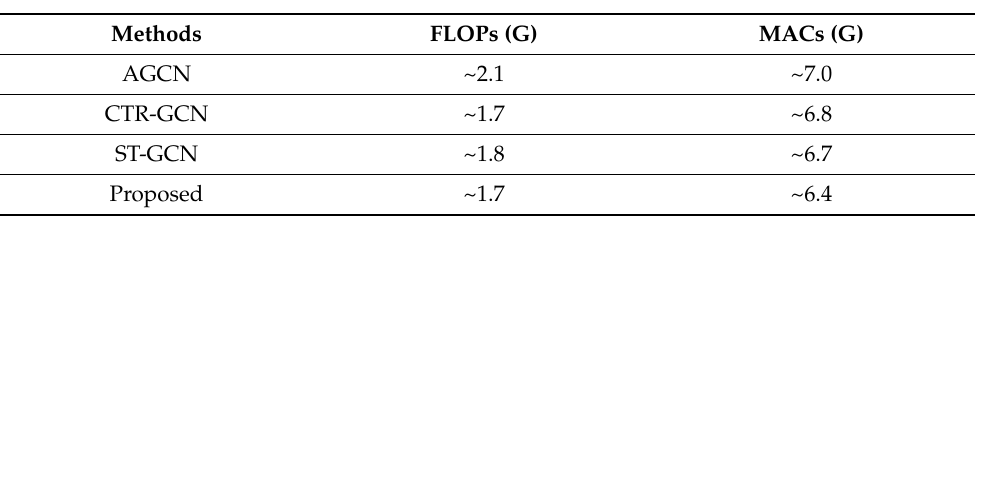
Table 6. Performance of the different